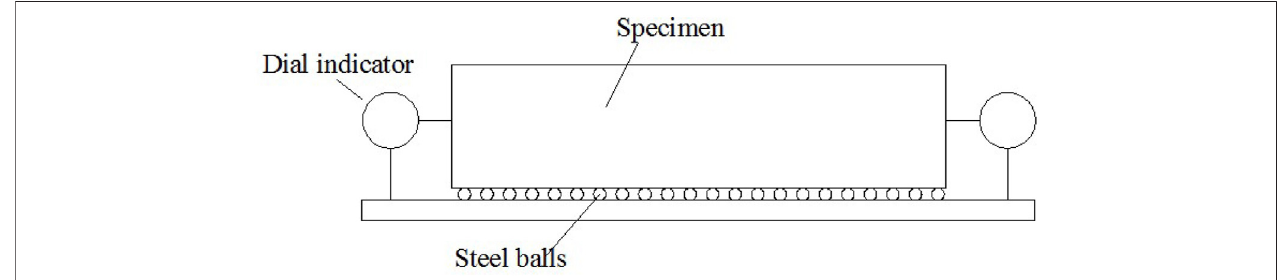
FIGURE 4 | Schematic diagram of the drying shrinkage test device.